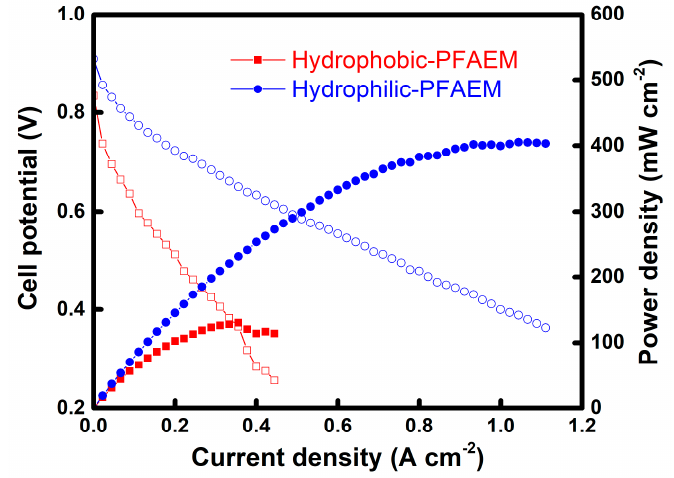
Figure 5. Time course changes in weight loss during the Fenton oxidation tests of anion-exchange membranes (AEMs).